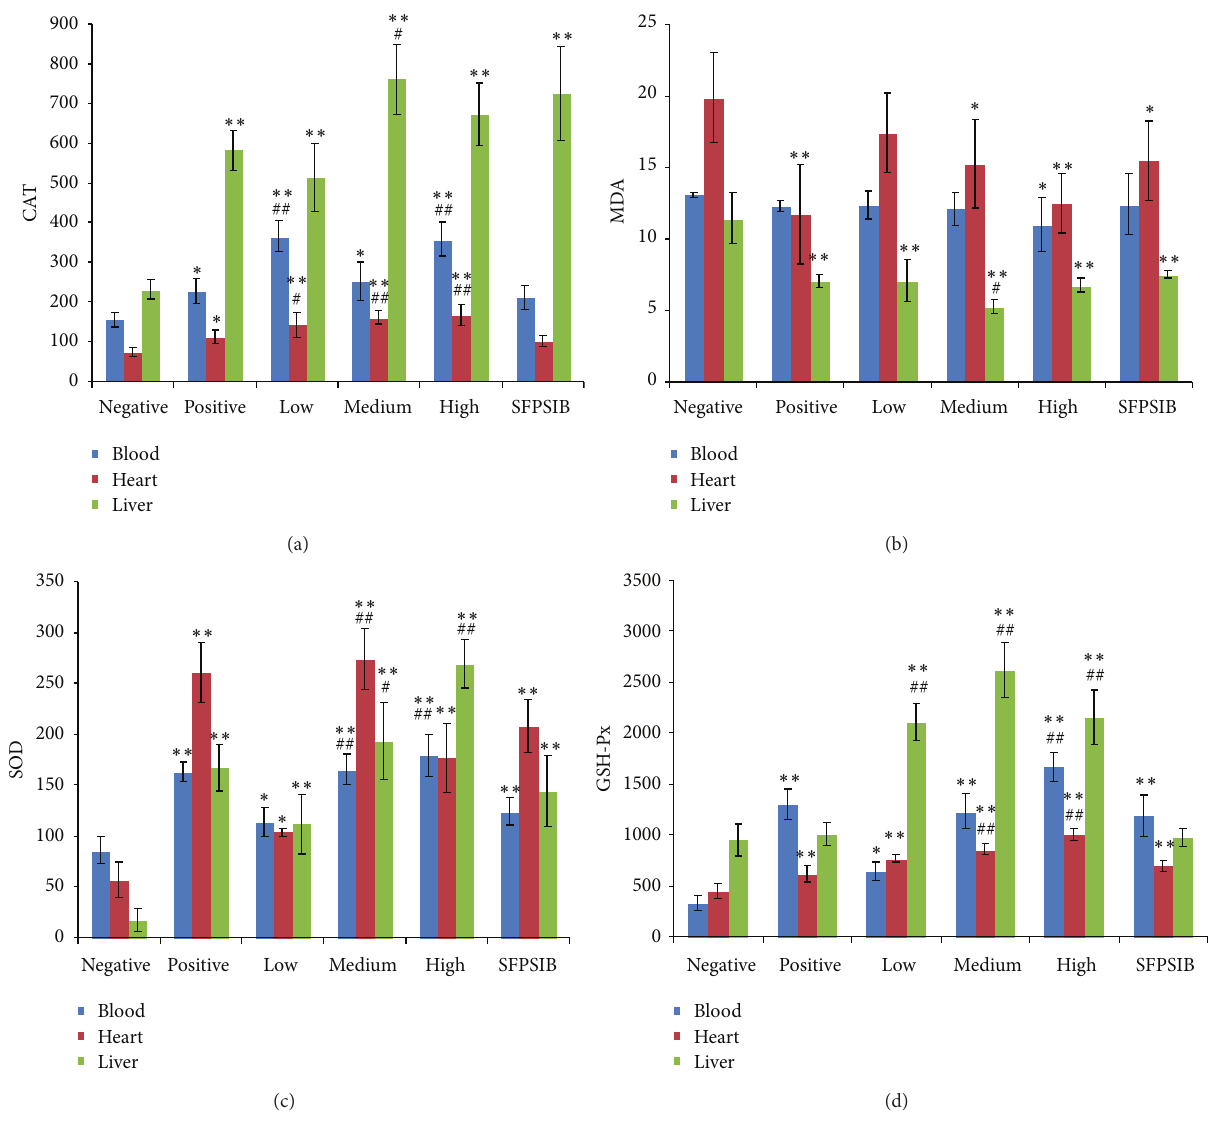
Figure 9: Effect of Se-SFPSIB on antioxidant system of mice bearing tumor S 180 in blood, heart, and liver. Compared with negative group, ∗ 𝑃 < 0.05 , ∗∗ 𝑃 < 0.01 ; compared with SFPSIB group, # 𝑃 < 0.05 , ## 𝑃 < 0.01 . (a) Effect of Se-SFPSIB on CAT in blood (U/gHb), heart, and liver (U/gport); (b) effect of Se-SFPSIB on MDA in blood (nmol/mL), heart, and liver (nmol/mgport); (c) effect of Se-SFPSIB on SOD in blood (U/mL), heart, and liver (U/mgport); (d) effect of Se-SFPSIB on GSH-Px in blood (U/mL), heart, and liver (U/gport).